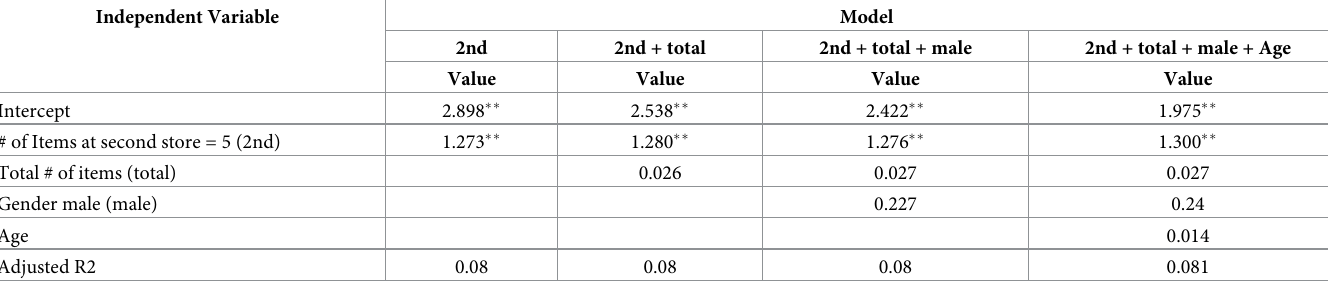
Table 11. Linear Regression results against likelihood (n = 293) (Study 2).